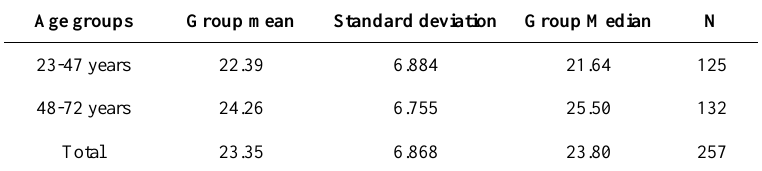
Table 3. Scores for the affective component of the attitudes towards inclusive education – age groups Age groups Group mean Standard deviation